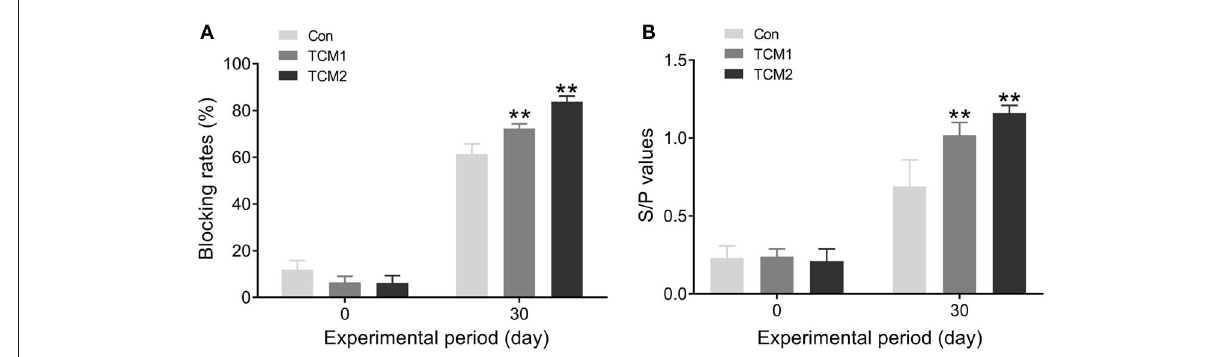
FIGURE3 Effect of TCM1 and TCM2 on CSFV and PRRSV antibodies in finishing swine. (A) The concentration of CSFV antibody. (B) The concentration of PRRSV antibody. “*” indicates a significant difference compared with control group (* P < 0.05 and ** P < 0.01).